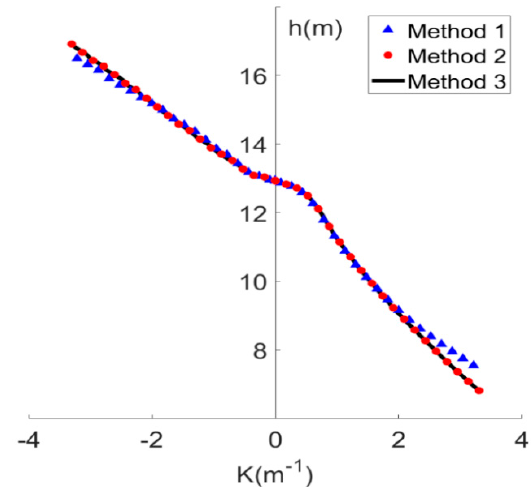
Figure 12. Height of neutral axis in CASE 2.